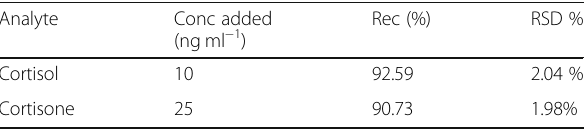
Table 3 The Recovery and RSD values of cortisol and cortisone standard solution spiked in the artificial saliva sample for three different electrodes